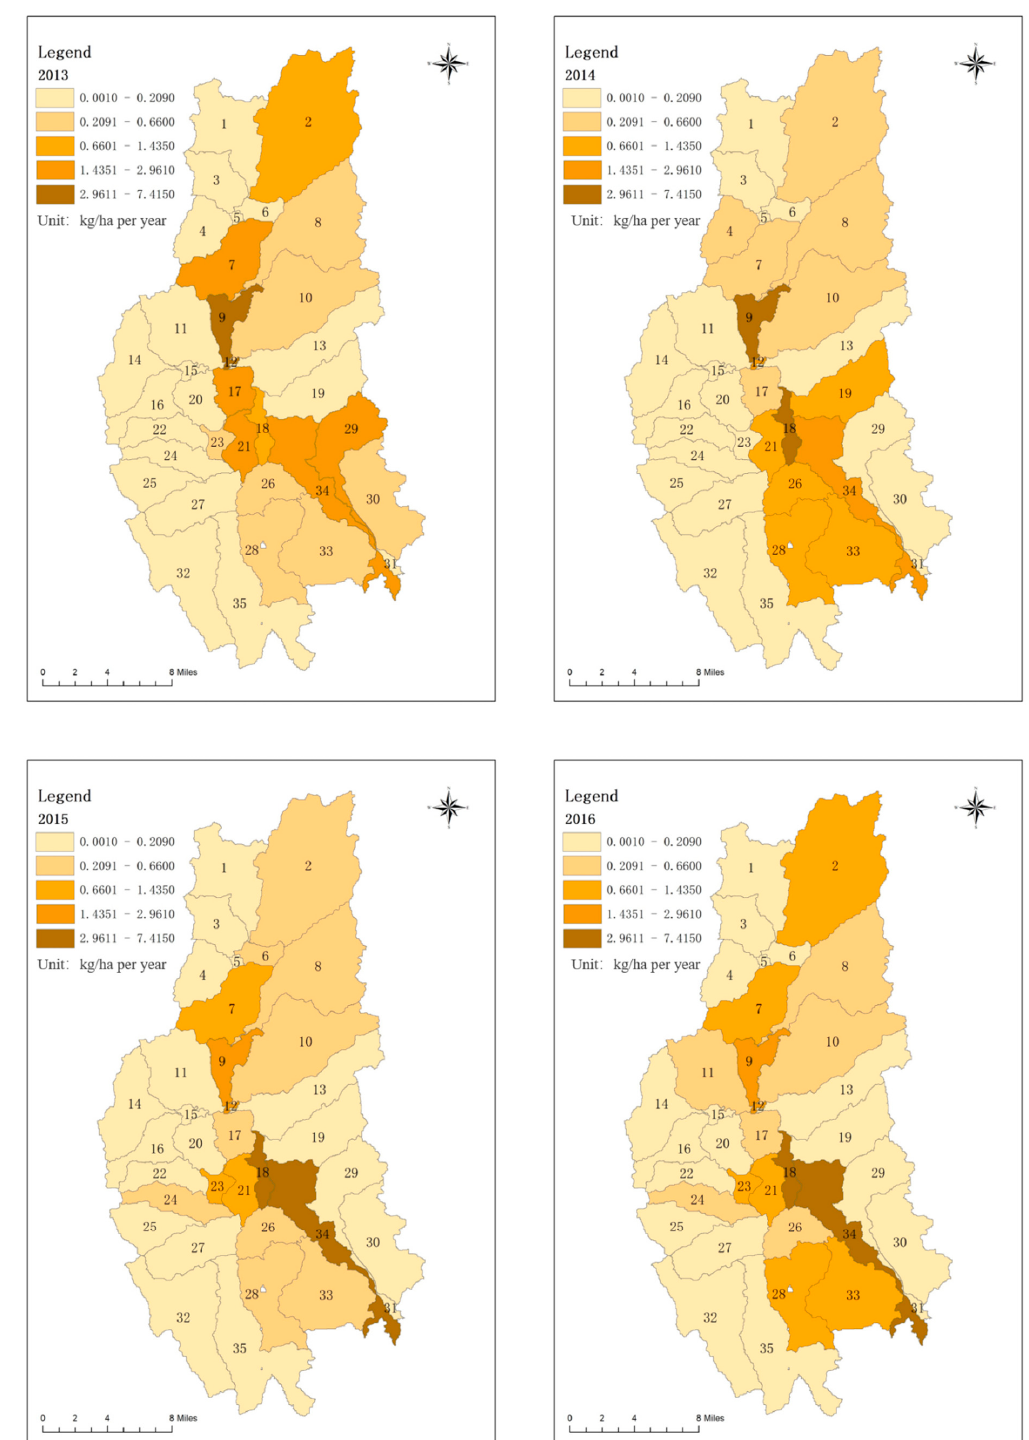
Figure 5. Sub-basin N export to Erhai Lake from 2013 to 2016.